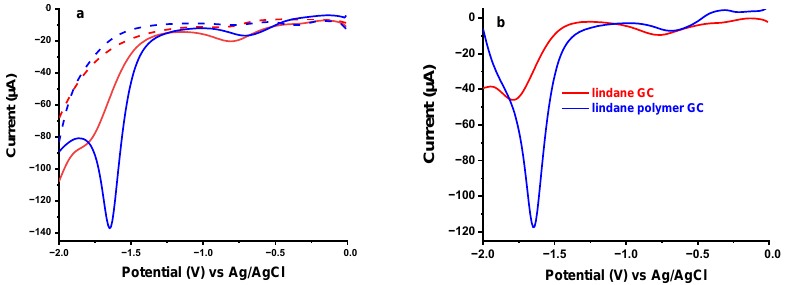
Figure 2. Square wave voltammogram in the absence (broken) and presence (solid) of lindane in 0.2 M KCl solution at bare (red) and polymer modified (blue) glassy carbon electrode ( a ) and background corrected response at bare (red) and polymer modified (blue) electrode ( b ). SWV conditions: E step = 0.01 V; Amplitude = 0.1 V; Frequency = 15.0 Hz.